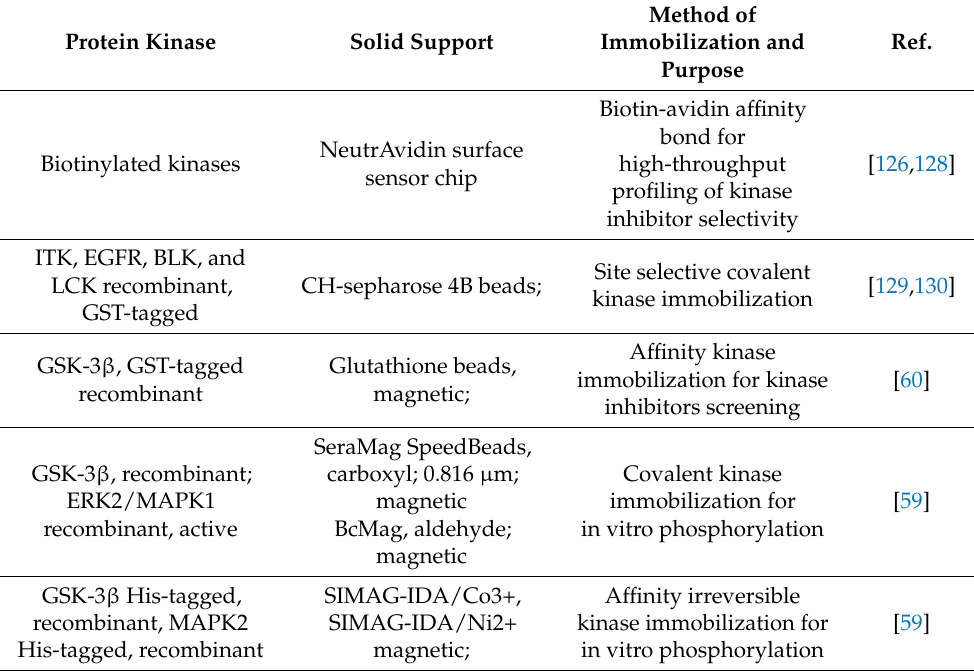
Table 1. List of immobilized protein kinases applied for in vitro phosphorylation. Protein Kinase Solid Support Biotinylated kinases ITK, EGFR, BLK, and LCK recombinant, GST-tagged